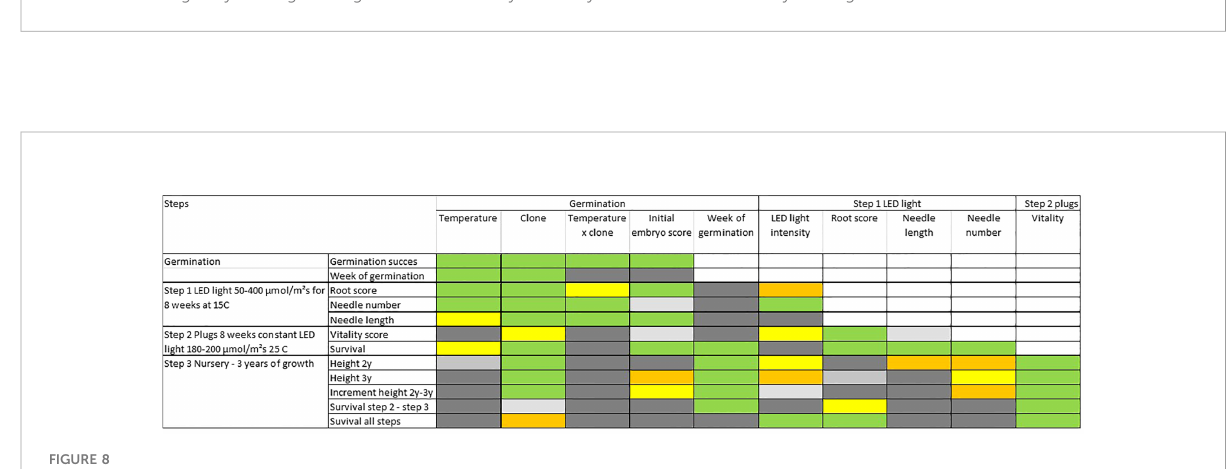
FIGURE 8 Results from statistical analyses of covariance (ANCOVA) describing how important each effect is for the trait of interest during steps 1 to 3. Colors describes probability levels (signi fi cance) of F-tests for each factor or covariate: Green <0.1%, orange 0.1-0.99, yellow 1-4.99%, light grey 5-10%, grey